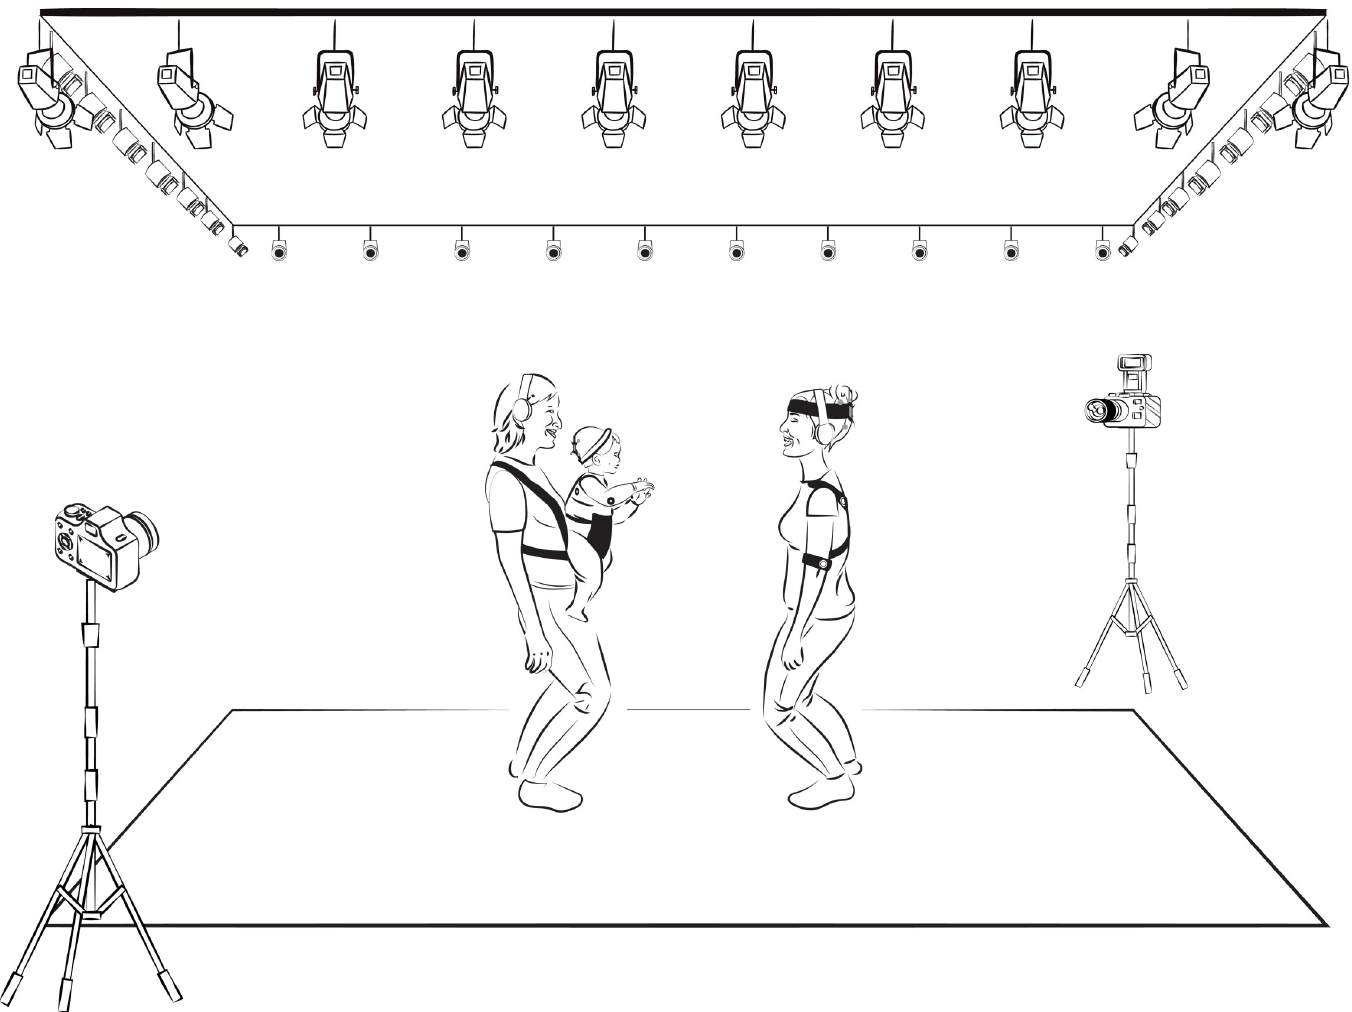
Fig 2. Depiction of the room setting and spatial disposition of the participants in nonspontaneous interaction context. During the bouncing session, the assistant that held the infant and the unknown adult were standing in front of each